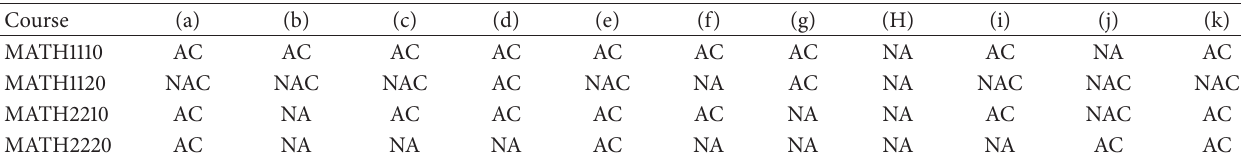
Table 11: Average ABET outcomes achievement level based on learning assessment tools (AC: achieved, NAC: not achieved, and NA: not applicable).